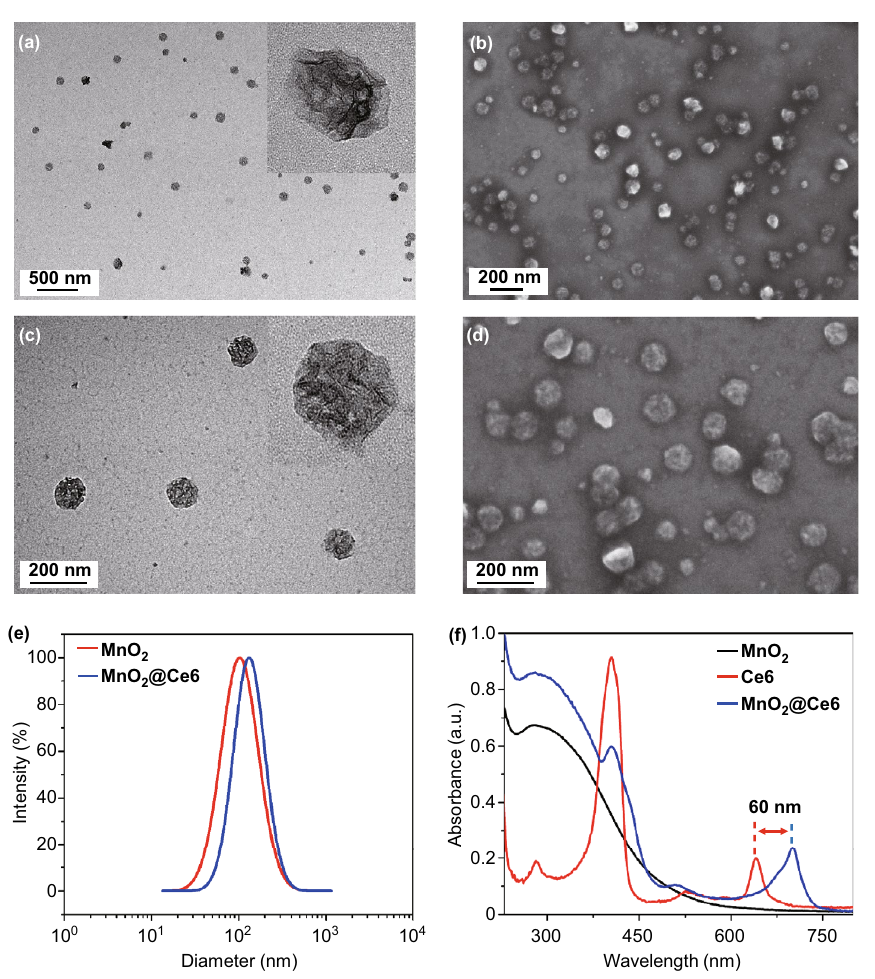
Fig. 1 Characterization of MnO 2 @Ce6. a TEM and b SEM image of MnO 2 nanoparticles. c TEM and d SEM image of MnO 2 @Ce6 nano- probes. e Size distribution of MnO 2 and MnO 2 @Ce6. f UV–vis absorption spectra of MnO 2 , Ce6, and MnO 2 @Ce6